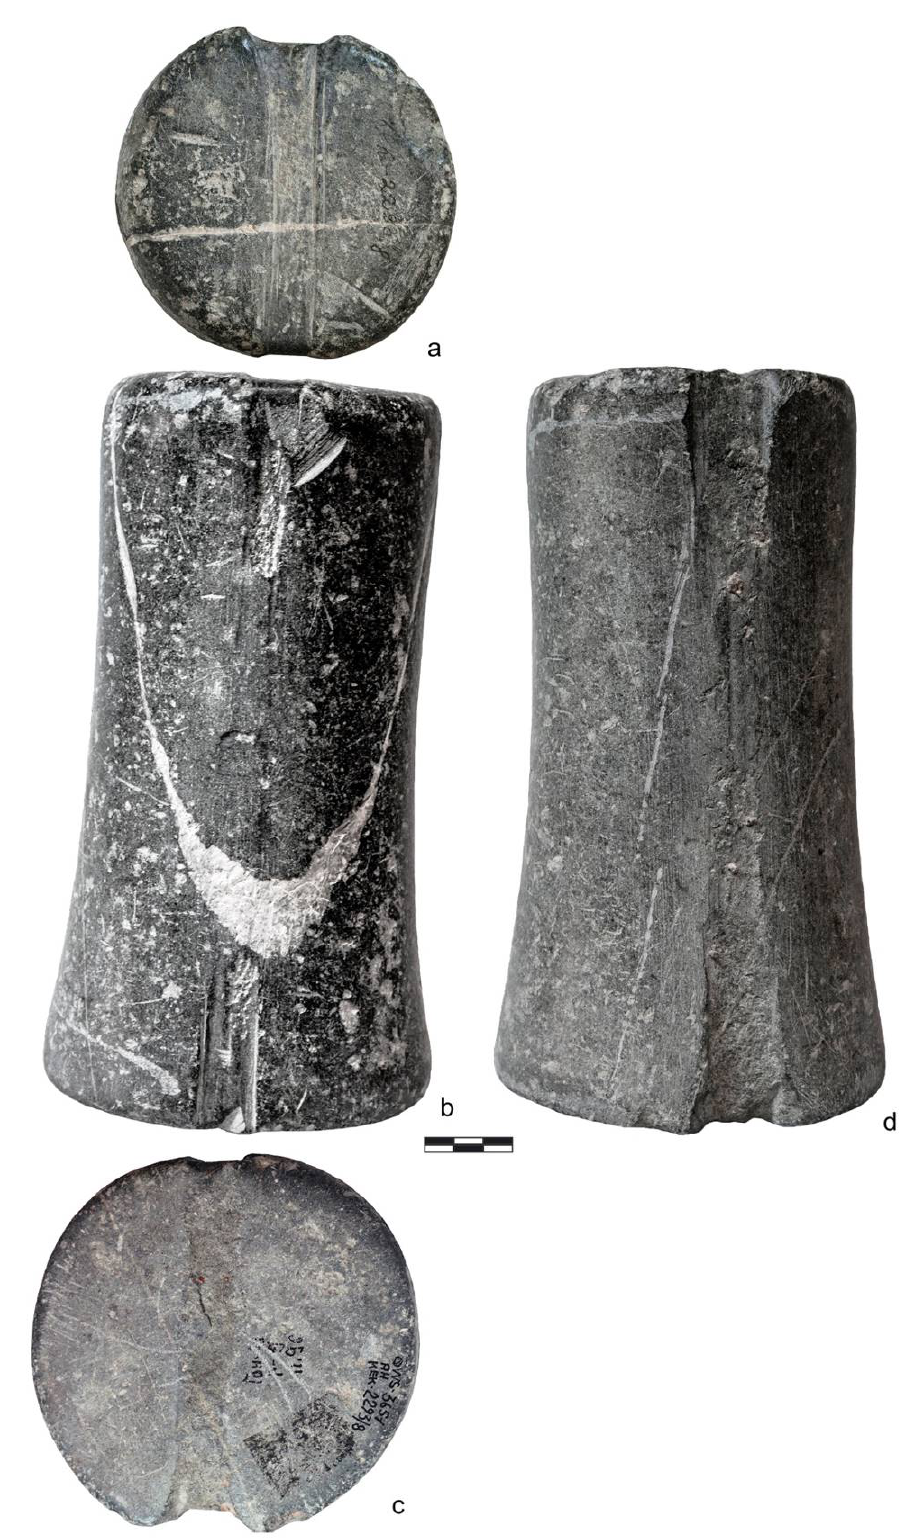
Figure 12. A variant of the arrangement of the grooves on the side of miniature columns from Gonur Depe (from the depositories of the National Museum of Turkmenistan, Ashgabat): a-c. narrow groove with a rectangular profile; d. wide groove with a rectangular profile. Scale bar is 3 cm long, separated into three 1 cm segments. Scale bar is 3 cm long, separated into three 1 cm